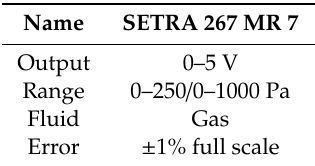
Table 2. Pressure transducers characteristics.